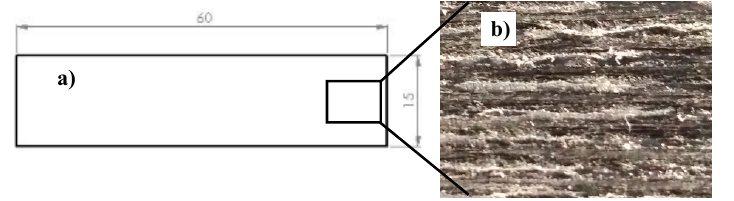
Figure 9. Three-point bending sample; ( a ) sample drawing, dimensions in mm; ( b ) fiber orientation detail (c) the authors, CC BY-NC-ND 4.0 [17].